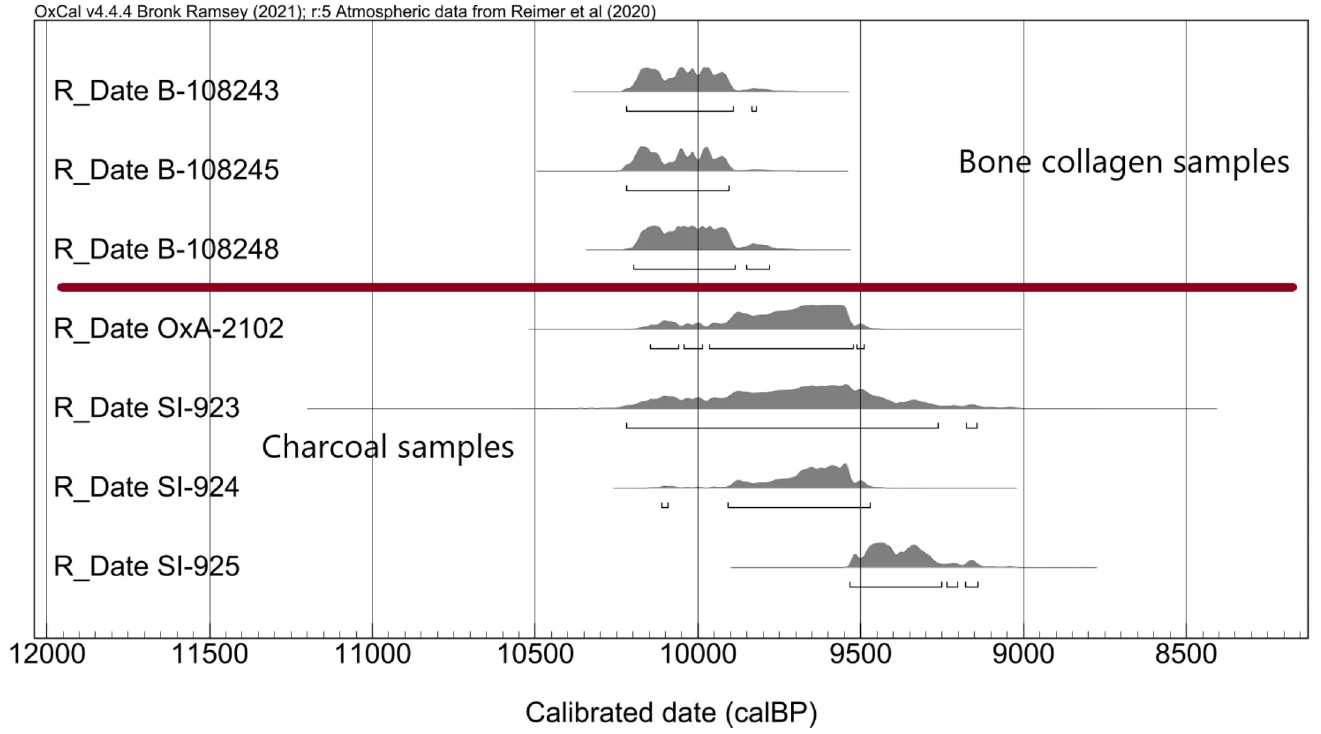
Fig 13. Calibrated radiocarbon ages of the positioned samples in the West